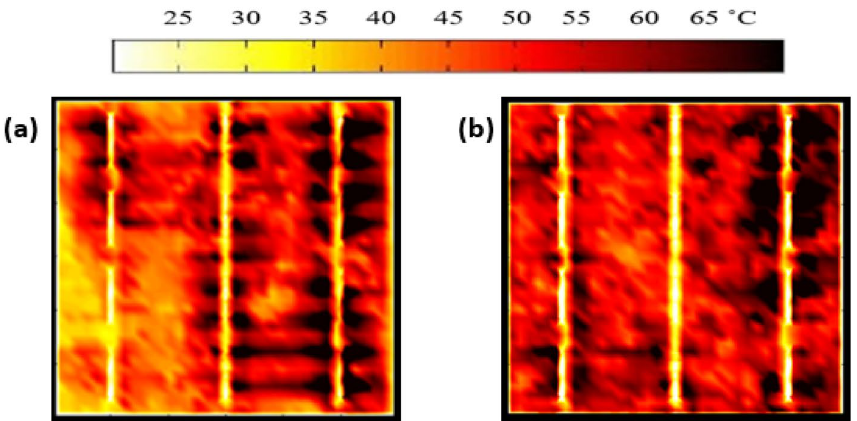
Figure 10. Thermal image of the solar cell samples after the PID test was completed ( a ) Sample #1, ( b ) Sample